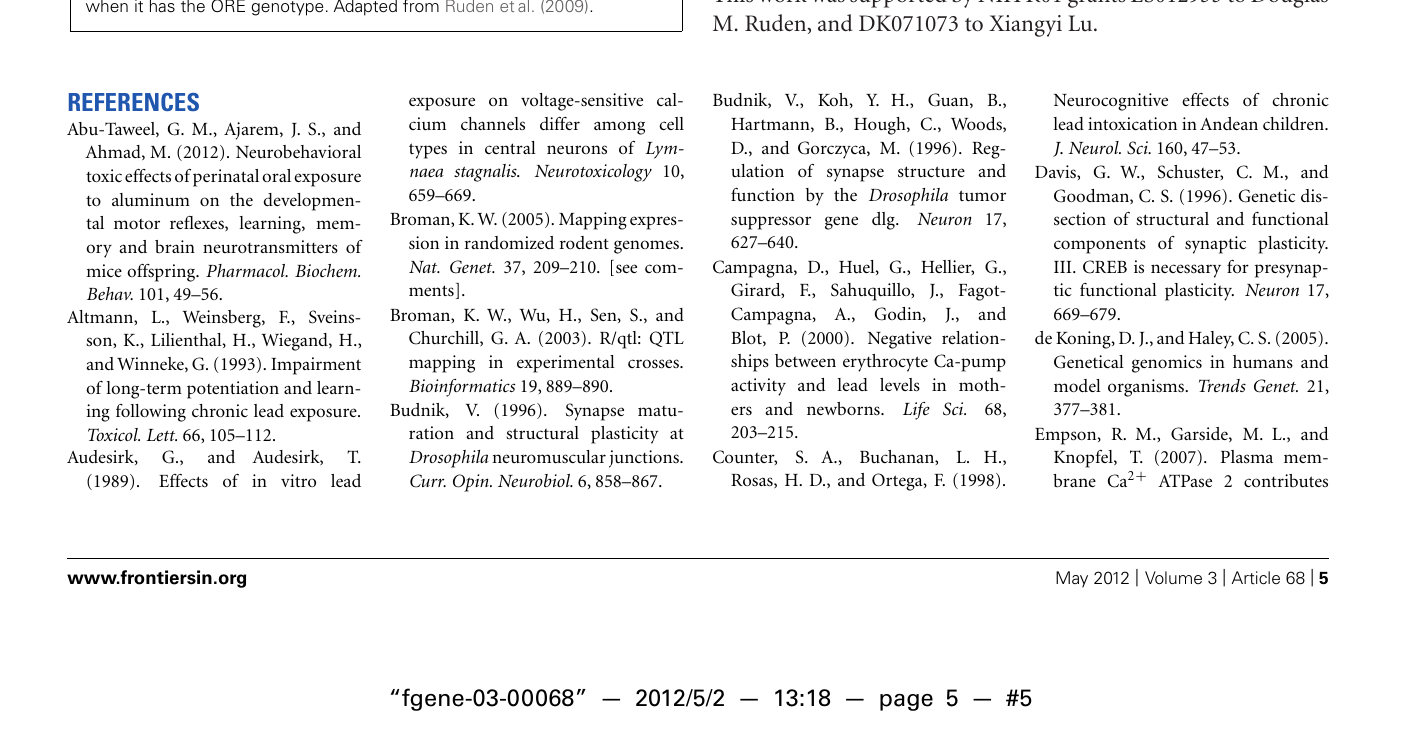
FIGURE 3 | Genetical genomics results of Drosophila recombinant inbred lines with developmental lead exposure. (A) The x -axis is the chromosome locations of the cis - and trans -eQTLs in centimorgans (cM). The y -axis is the location of the transcript in mega-base pairs (Mbp).The eQTLs in control (red) and the eQTLs treated (black) are indicated as dots and crosses, respectively.The locations of the control trans -eQTL are shown on top in red and the lead-treated trans -eQTL locations are shown in black letters. Many of the eQTL at 70D in the control flies shift to 30AB in the lead-treated flies (red arrow at top). (B) The trans -activator encoded by the 73D hotspot is required for basal transcription of the 33 genes co-regulated by both 73D and 30AB master modulatory genes. (C) In the presence of lead, the trans -regulator encoded by the 73D hotspot further increases steady-state mRNA levels when it has either the ORE or 2B genotype. However, the trans -regulator encoded by the 30AB hotspot further increases steady-state mRNA levels for the 33 target genes only when it has the ORE genotype. Adapted from Ruden etal.